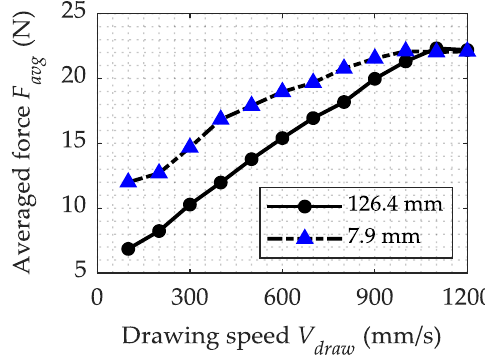
Figure 9. FEM calculation results of average ultrasonic drawing force with different drawing speeds with reel-die distance of 126.4 mm and 7.9 mm.